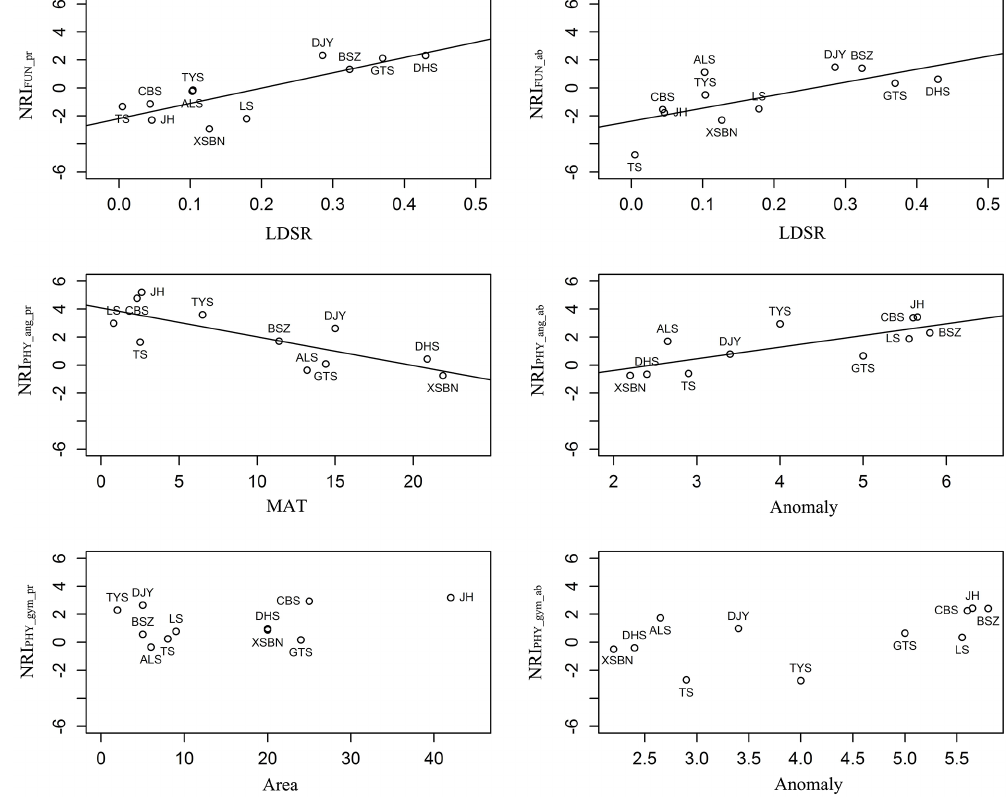
Fig. 2. Scatter plots of each diversity index against its best predictor. Linear regression fits are given for significant relationships. NRI FUN : functional ( H max ) NRI, and NRI PHY : phylogenetic NRI, based on either presence–absence ( pr ) or abundances ( ab ) with gymnosperms ( gym ) or only considering angiosperms ( ang )